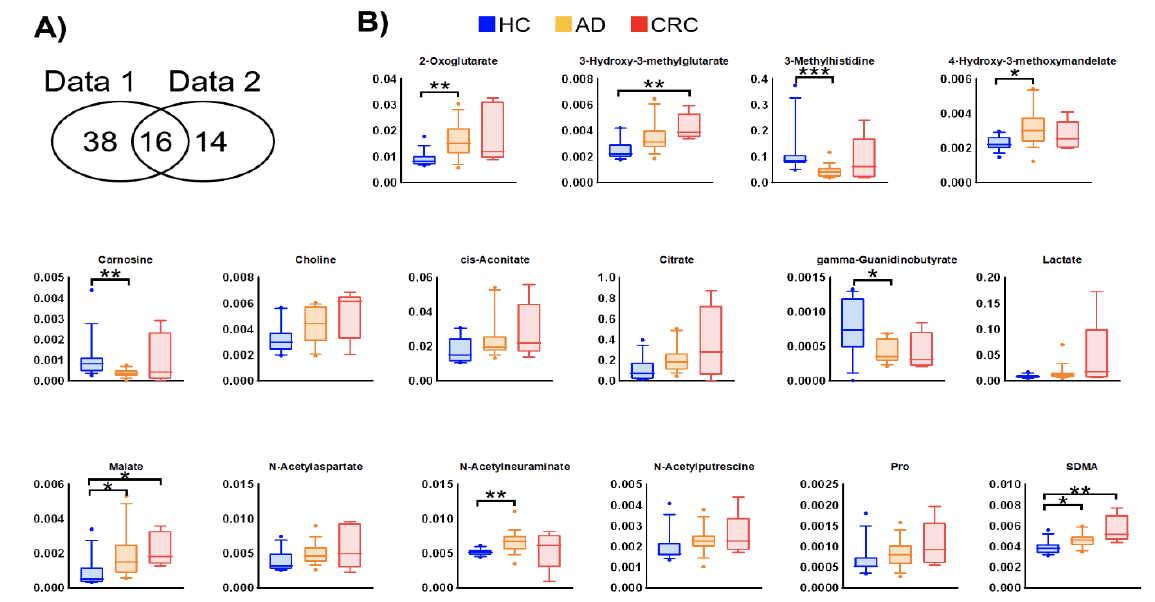
Figure 2. Metabolites showing consistent changes between data 1 and data 2. ( A ) Venn diagram of metabolites with a significant difference ( p < 0.05, Mann–Whitney U test in HC vs. AD + CRC) in both datasets. ( B ) Box plots of data 2 of each metabolite. The Y-axis is the concentration ( µ M). Horizontal bars indicate 90%, 75%, 50%, 25%, and 10%, and data on the outside are plotted. * p < 0.05, ** p < 0.01, and *** p < 0.001 (Dunn’s multiple comparison test following the Kruskal–Wallis test).